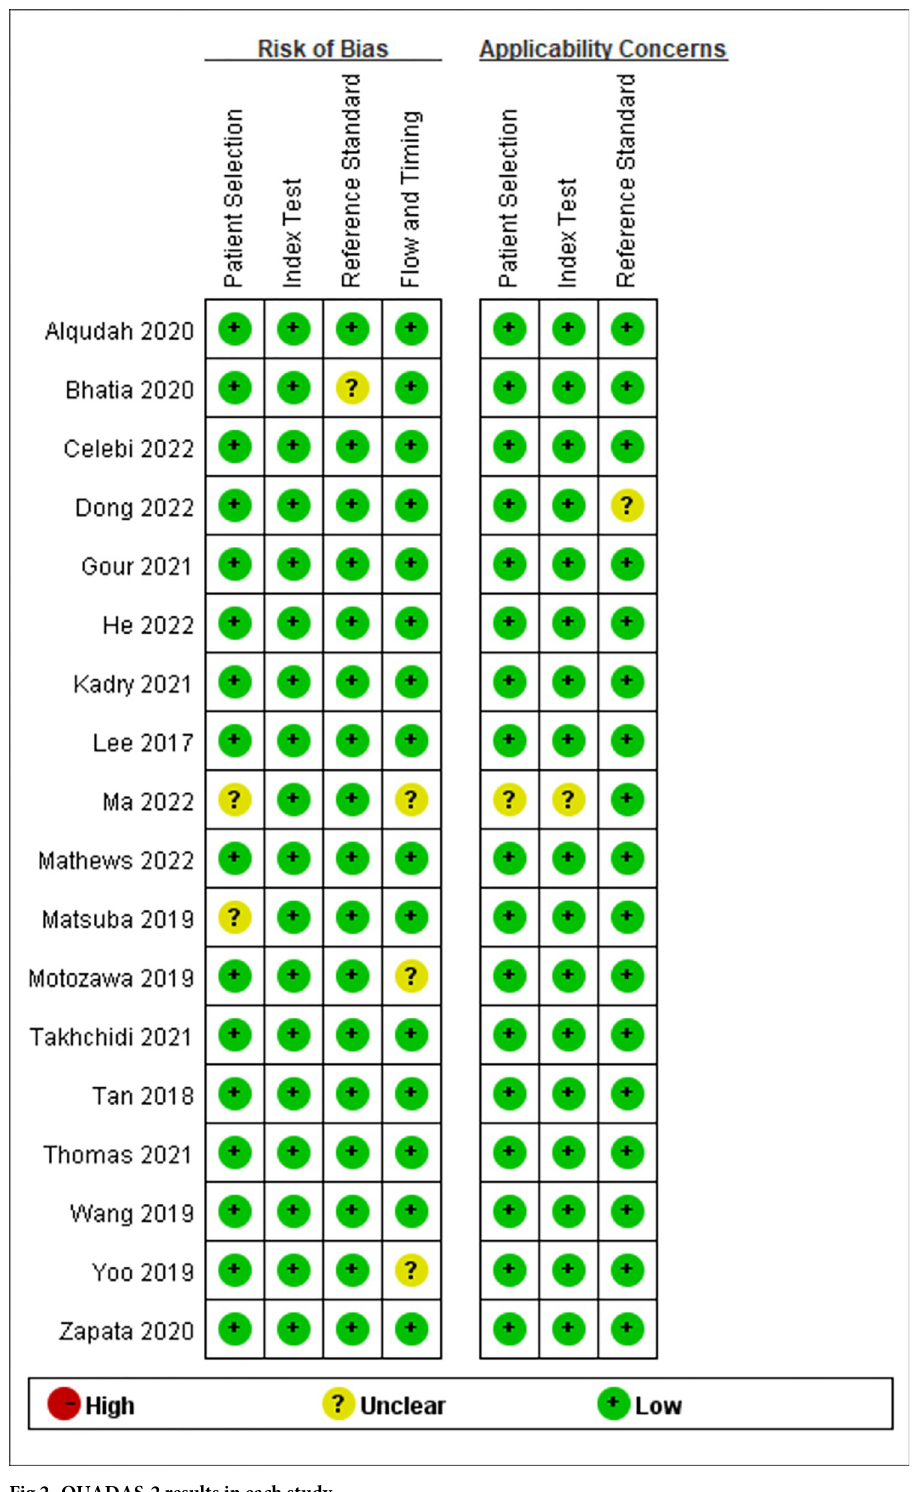
Fig 2. QUADAS-2 results in each